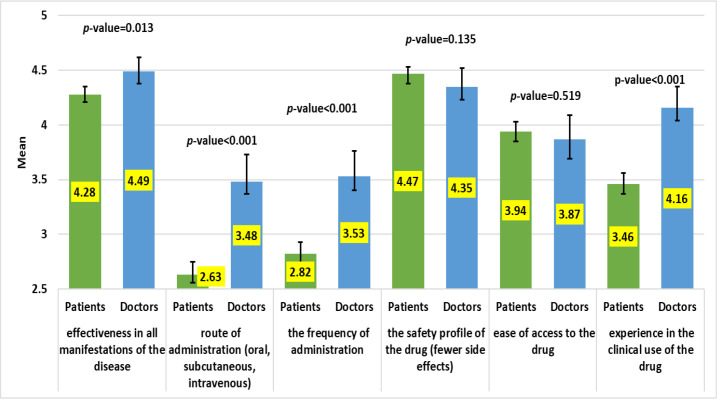
Importance of factors in determining the choice of treatment.Note: p-values from t-tests of the mean difference between doctors and patients’ responses for each dimension.